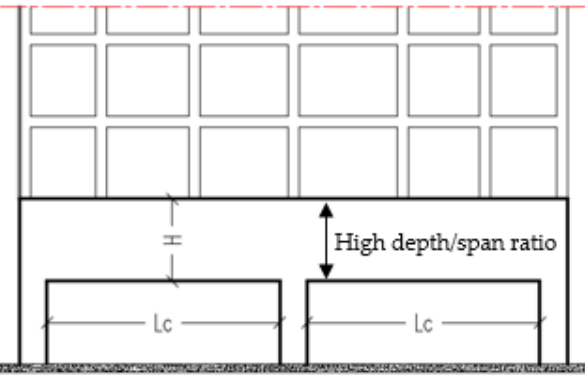
Figure 1. Illustration of a reinforced concrete continuous deep beam.